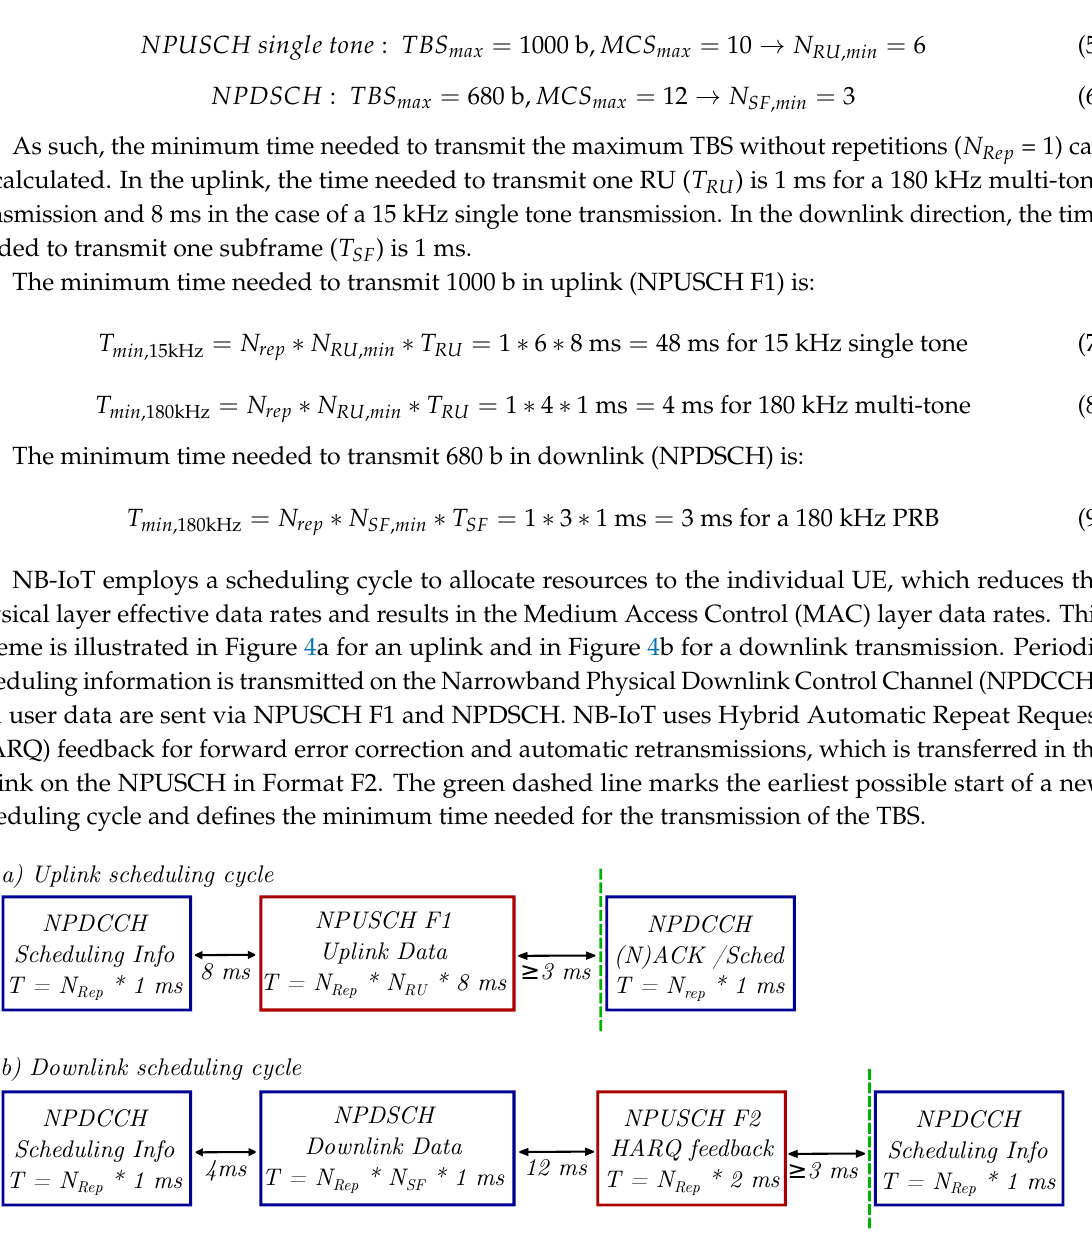
Figure 4. NB-IoT scheduling cycle for a single ( a ) uplink and ( b ) downlink transmission. Image adapted from